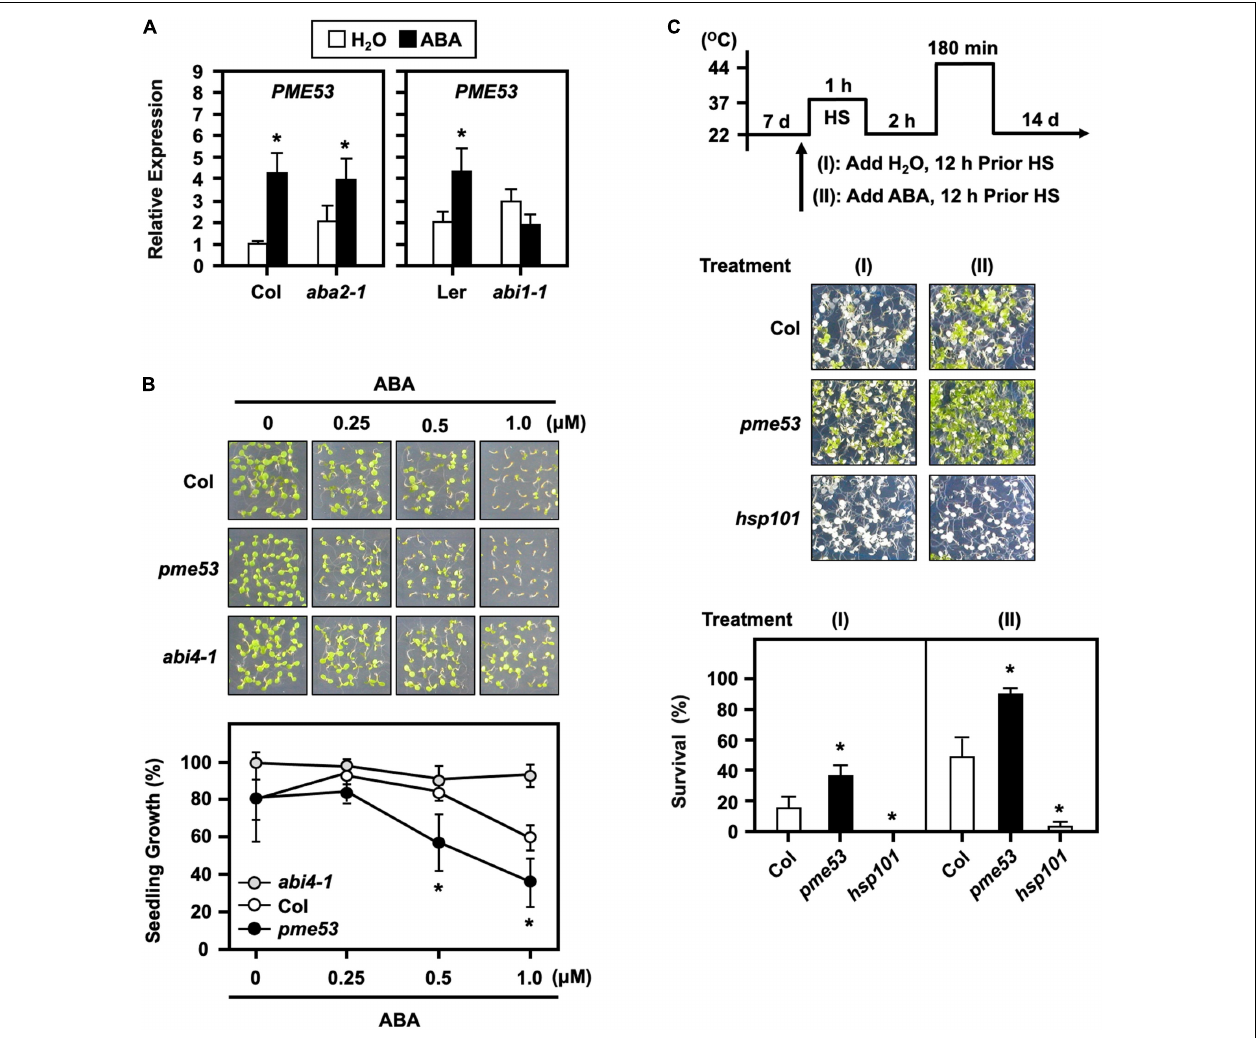
FIGURE 10 | Transcriptional levels of PME53 in ABA-deficient ( aba2-1 ) and ABA-insensitive ( abi1-1 ) mutant plants and the effect of ABA on pme53 mutant post-germination growth and in response to heat stress. (A) 7-day-old seedlings were treated without (H 2 O control) or with 30 µ M ABA for 3 h. The expression levels of PME53 were analyzed by q-PCR. The fold change expression was normalized relative to their corresponding wild-type (Col or Ler) plants. Data are mean ± SE of three biological replicates. *Significant at P < 0.05 compared with the Col or Ler. (B) Seedling growth without or with 0.25 to 1 µ M ABA on plates was photographed and measured at day 7 after planting. abi4-1 , an ABA-insensitive mutant, was used as reference. (C) The pictogram shows the heat stress regime. Plates were incubated with 2.5 mL H 2 O or 10 µ M ABA solution, 12 h before HS treatment. Seedlings were photographed and survival was measured at 14 days after the LHS treatment. hsp101 , a heat-sensitive mutant, was used as reference. Data are mean ± SE of three biological replicates ( n = 50 seedlings). *Significant at P < 0.05 compared with the